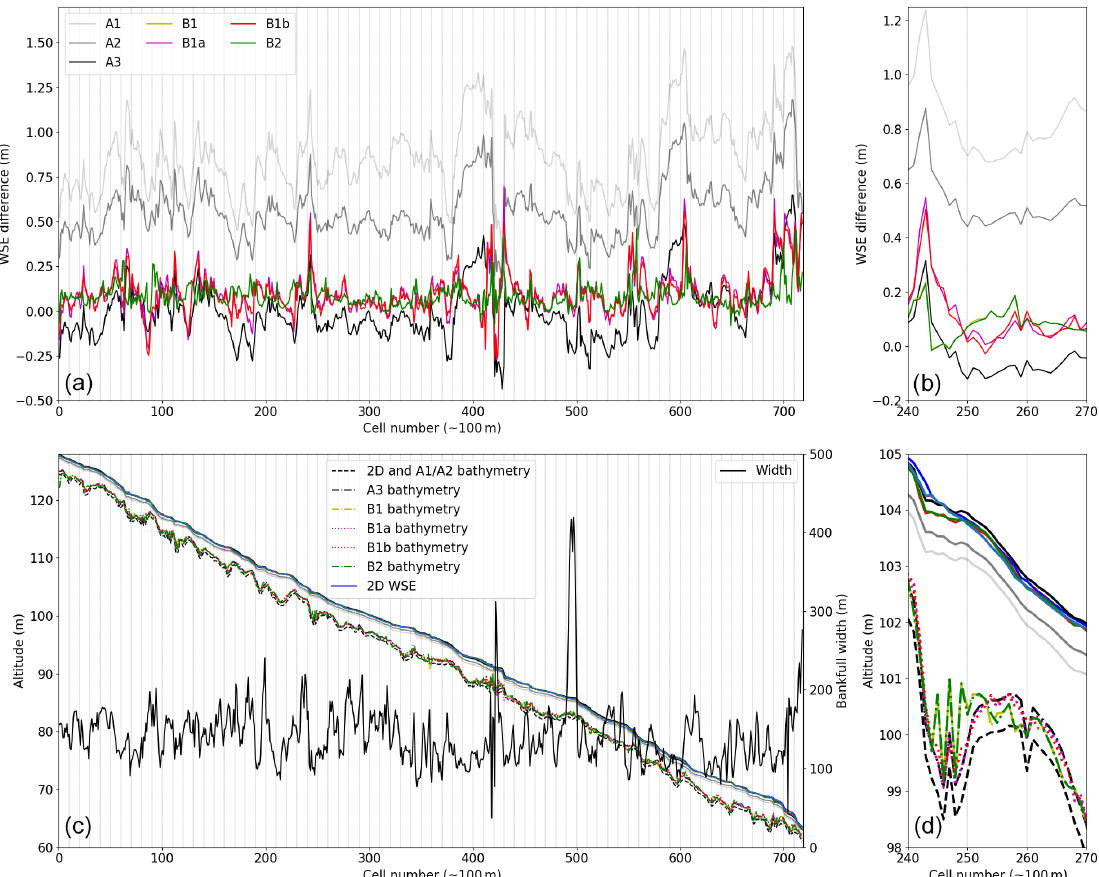
Figure 13. Comparison of seven 1D-like models of 72km of the Garonne River to a reference 2D SW fine model for a permanent flow (reference WS elevation in blue lines, c, d ). ( a ) WS comparison of 1D-like models to 2D reference model at each spatial point. (b) Zoom on 3km long reach of interest. ( c ) WS elevation and bathymetry for the reference and 1D like models. (d) Zoom on 3km long reach of interest. For models A1, A2 and A3 (in gray), the bathymetry and homogeneous friction are manually calibrated. For mode B1 (yellow), B1a (magenta), B1b (red) and B2 (green), the bathymetry and friction are calibrated by VDA. For models B1 and B2, inferences are carried out from observations at each cell (720 total). For models B1a and B1b, inferences are carried out from observations every 10 cells (i.e., around every 1km, 72 stations total). Vertical bars indicate these 72 stations.